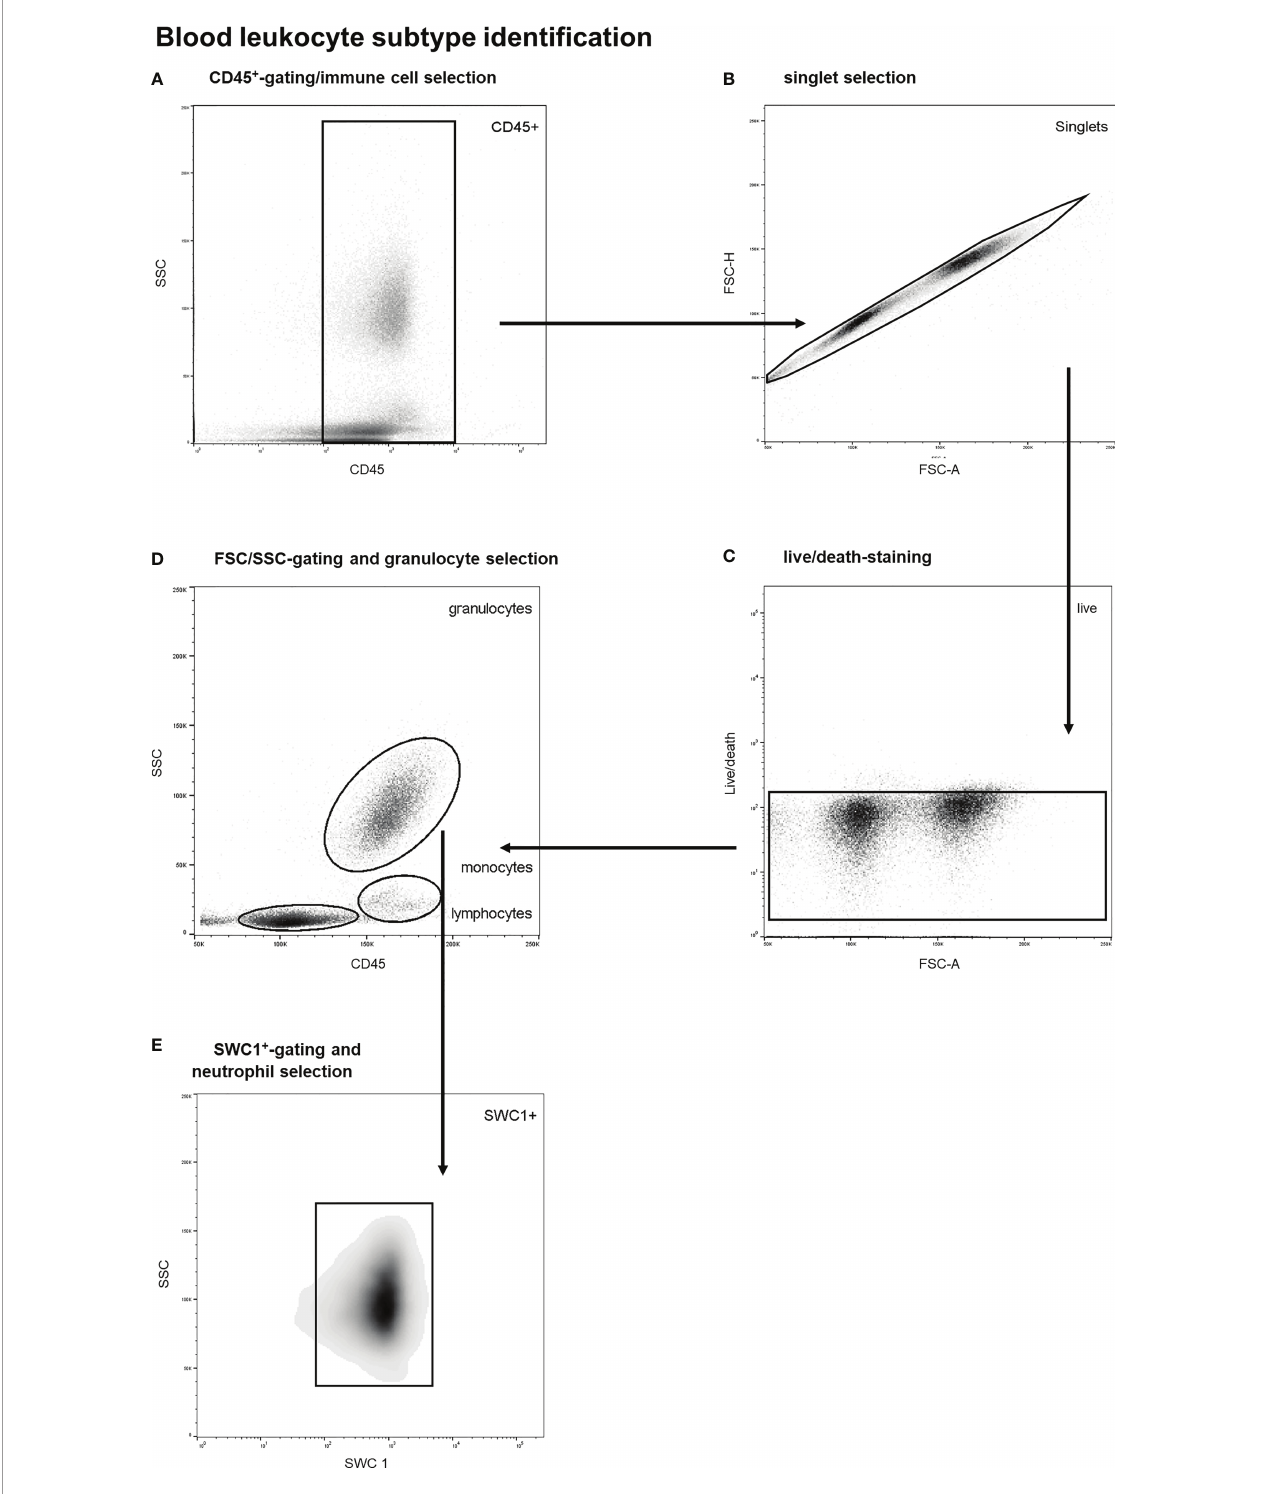
FIGURE 1 | Stepwise neutrophil gating protocol as utilized for identi fi cation of circulatory leukocyte subtypes and neutrophils. (A) Selection of CD45 positive cells and thereby the exclusion of debris and non-immune cells. (B) Exclusion of doublets. (C) Life/death-stain and selection of viable immune cells. (D) Identi fi cation of different leukocyte subtypes and subsequent selection of granulocytes using FSC/SSC-plots. (E) Selection of SWC 1 + cells, and thereby exclusion of eosinophils. SSC, sideward scatter signal; FSC, forward scatter